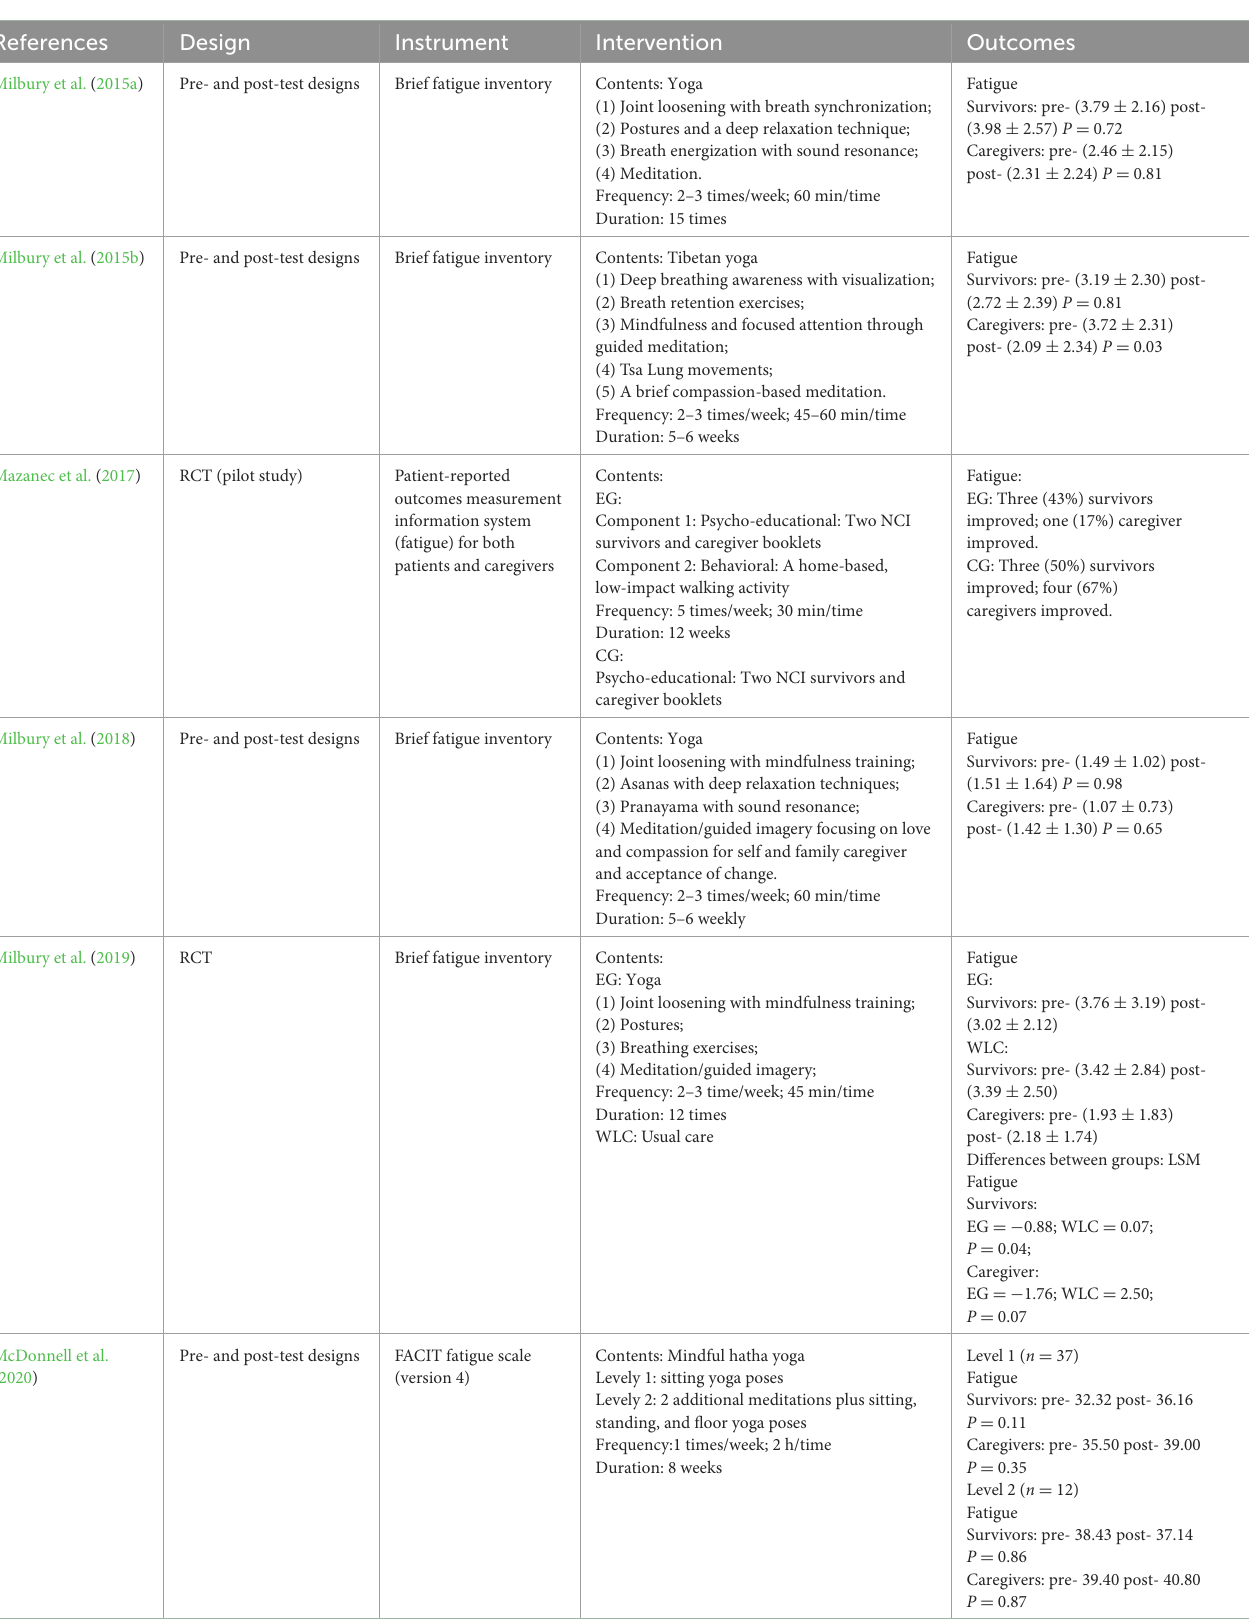
TABLE 2 Characteristics of included interventions in reviewed